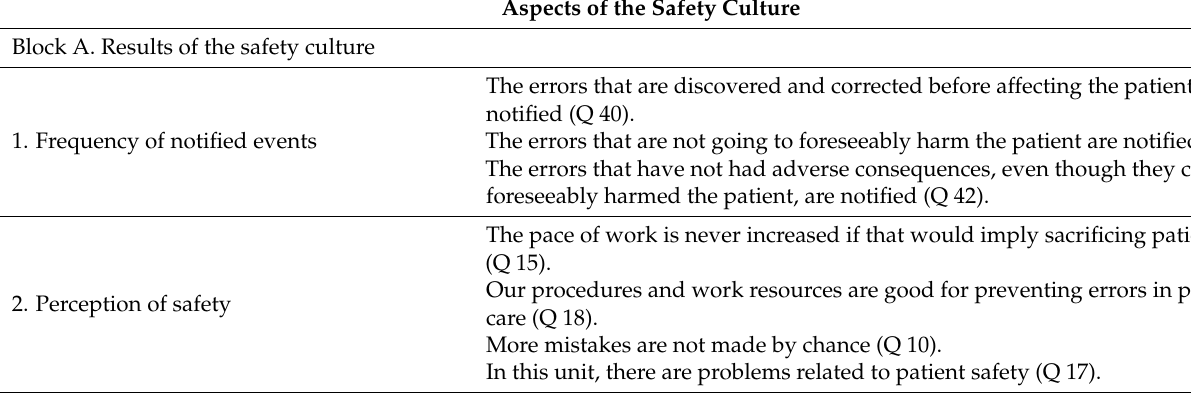
Table A1. Aspects of the safety culture and the items it includes. The corresponding question number on the questionnaire appears in